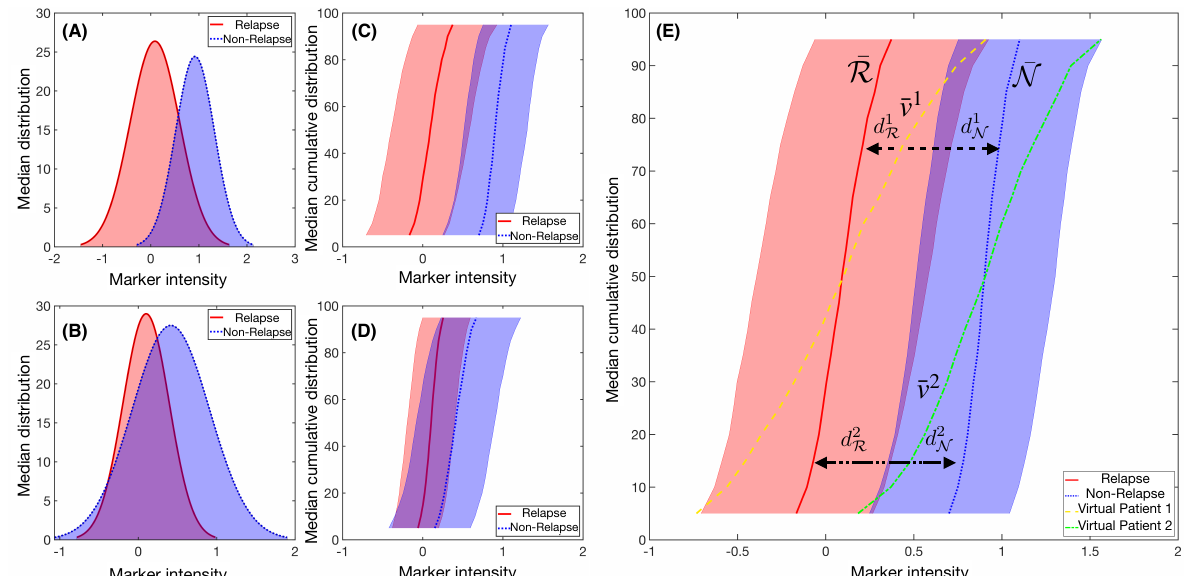
Figure 3. Example of synthetic IPT markers distributions. Mean distribution of a marker with, respectively, ( A ) high and ( B ) low Fisher’s Ratio, with ( C , D ) their respective cumulative distribution of the median the standard deviation values. ± ( E ) Median cumulative distribution of the two sets of patients for a marker with high Fisher’s Ratio. In solid red line, median cumulative distribution of relapsed patients ¯ R and in blue dotted line for the non-relapse ones. In yellow dashed line and green dashed dotted line the median cumulative distribution for the marker ¯ v i was represented for two different virtual patients i . The distances to each set median, d i and d i , are represented with black headed arrows, with dashed lines R N for Patient 1 and dashed dotted lines for Patient 2. In this example, Patient 1 would be considered to be a relapsed patient, while Patient 2 would belong in the non-relapsed